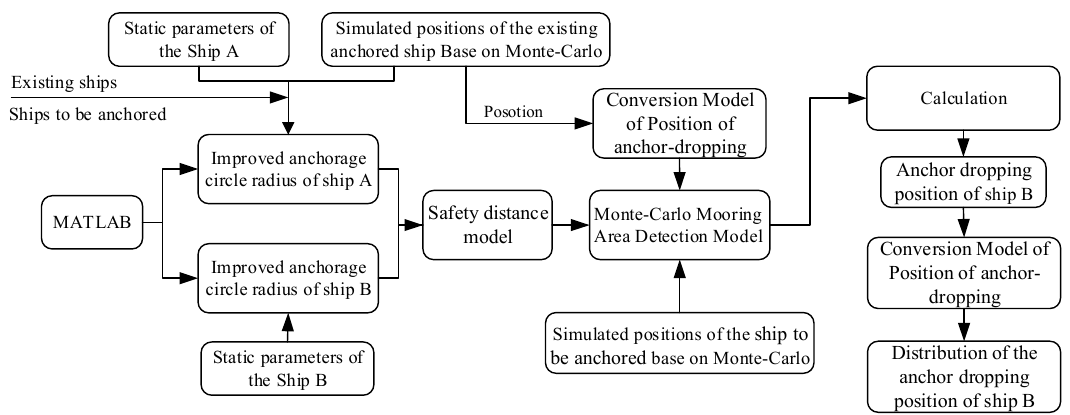
Figure 7. Diagram of simulation.